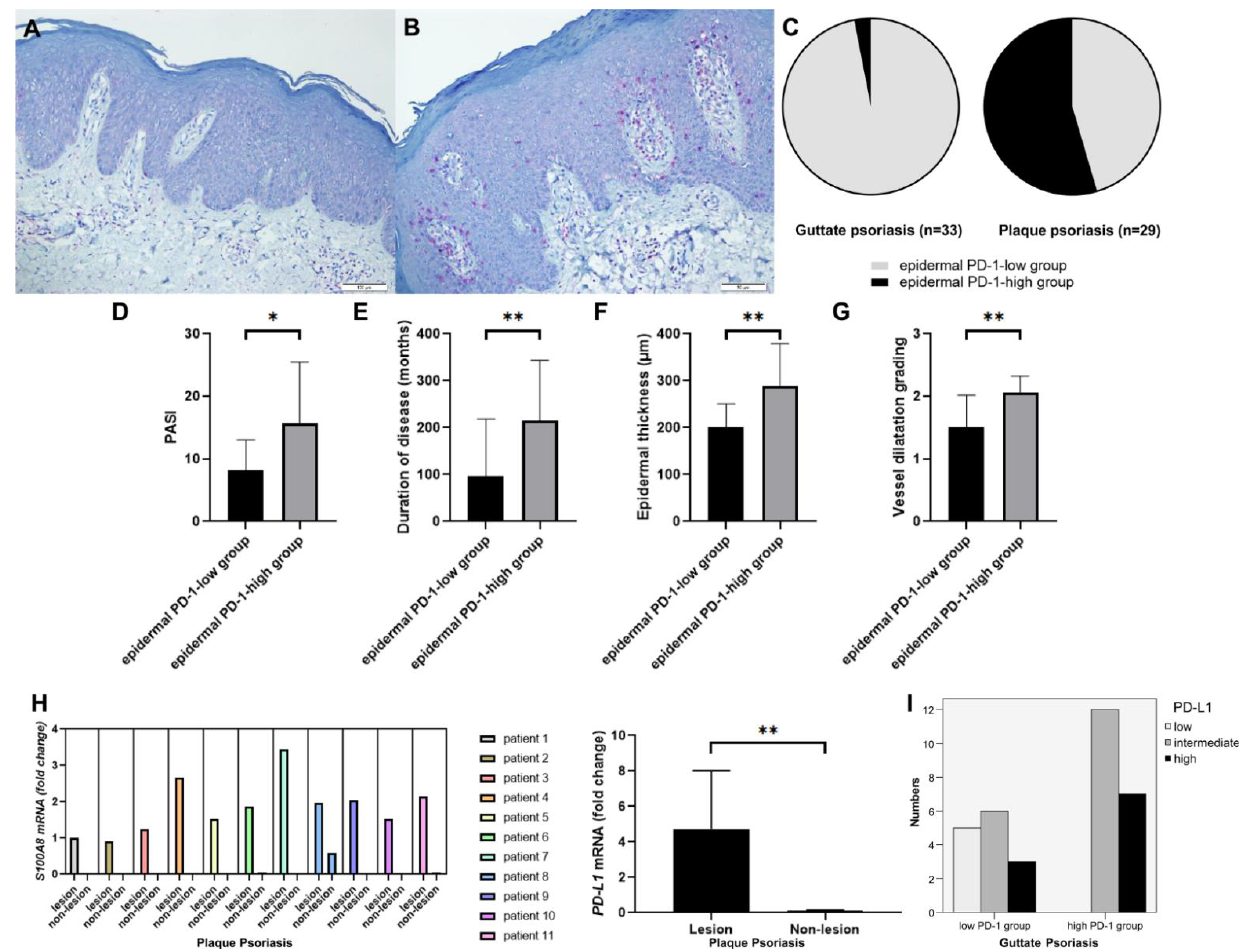
Figure 1. Clinical and histopathological characteristics of patients with chronic plaque psoriasis (CPP) in the PD-1-high and PD-1-low groups. ( A – C ) Of the 29 patients, 14 and 15 patients were assigned to the epidermal PD-1-low and epidermal PD-1-high groups, respectively. Among the 33 patients with GP, epidermal PD-1 expression was only detected in 1 patient. ( D ) The PASI scores in the epidermal PD-1-high group was significantly higher than that in the epidermal PD-1-low group ( p = 0.014). ( E ) Disease duration in the epidermal PD-1-high group was significantly higher than that in the epidermal PD-1-low group ( p = 0.009). ( F ) The thickness of the epidermis in the epidermal PD-1-high group was significantly greater than that in the epidermal PD-1-low group ( p = 0.004). ( G ) The grade of vessel dilatation in the epidermal PD-1- high group was significantly higher than that in the epidermal PD-1-low group ( p = 0.002). ( H ) Compared with those in the non-lesional skin, the mRNA expression levels of S100A8 were upregulated in the lesional skin. The mRNA level of PD-L1 in lesional skin was significantly higher than that in non-lesional skin ( p = 0.002). ( I ) The level of IHC positivity of PD-L1 in the dermal PD-1-low group of guttate psoriasis was significantly lower than that of dermal PD-1-high group ( p = 0.03, Fisher’s exact test ). * p < 0.05, ** p < 0.01.